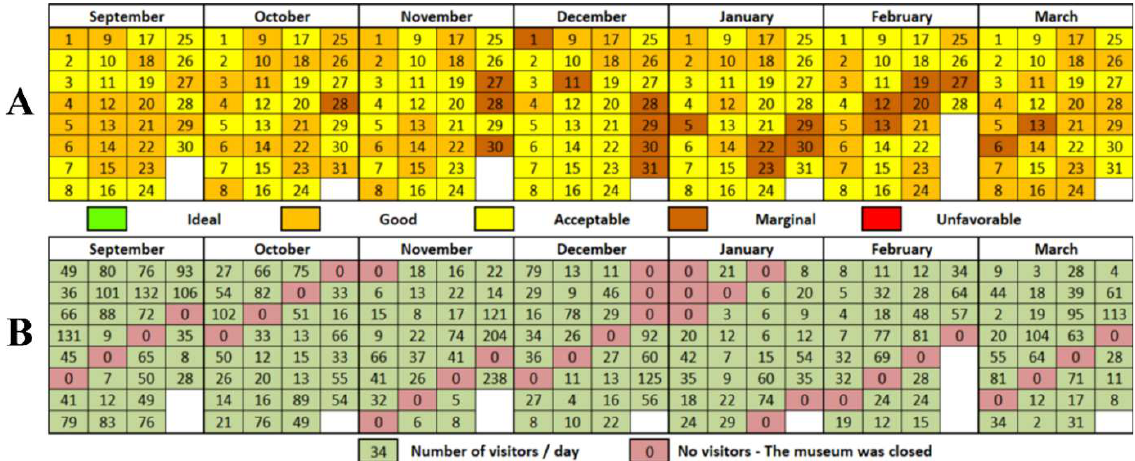
Figure 11. The quality of indoor microclimate expressed on each of the 212 monitoring days (( A )—the days in which the values of the 15 indicators recorded ideal/good/acceptable/marginal/unfavorable conditions according to the standards in force; ( B )—the number of visitors registered for each of the internal microclimate monitoring days) .